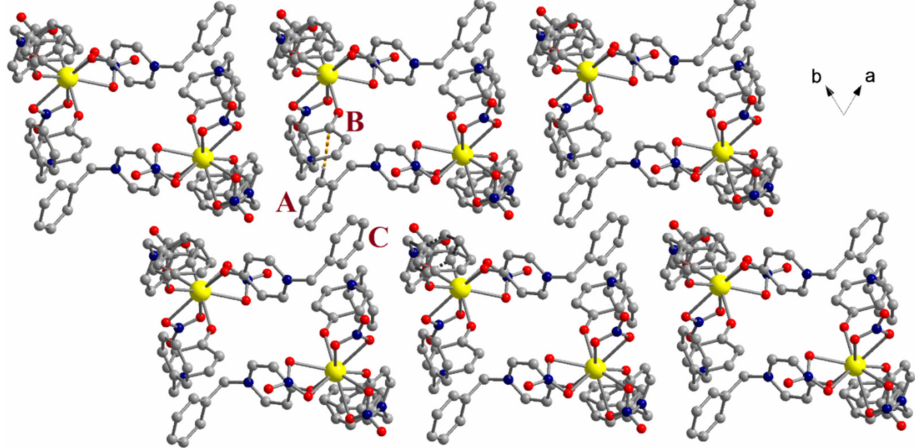
Figure 2. View of the packing diagram of the compound 5c along the crystallographic c